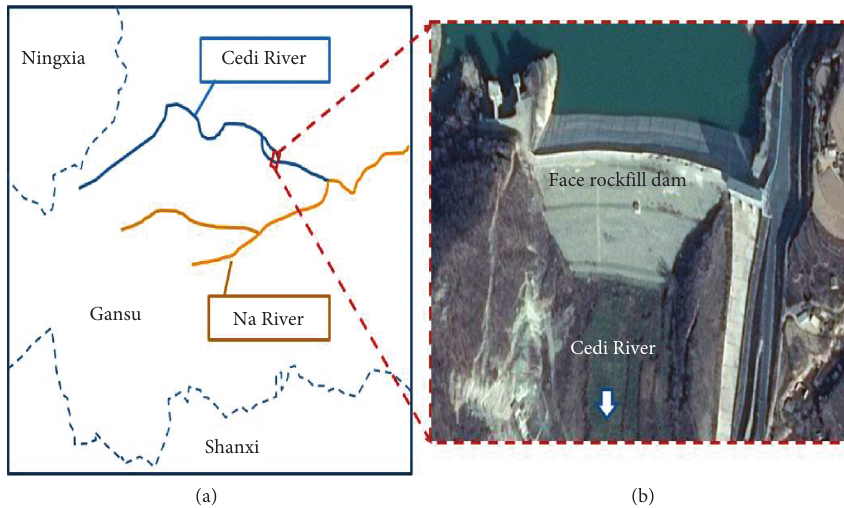
Figure 1: Shibaozhai CFRD on the Cedi River in Gansu Province, China.